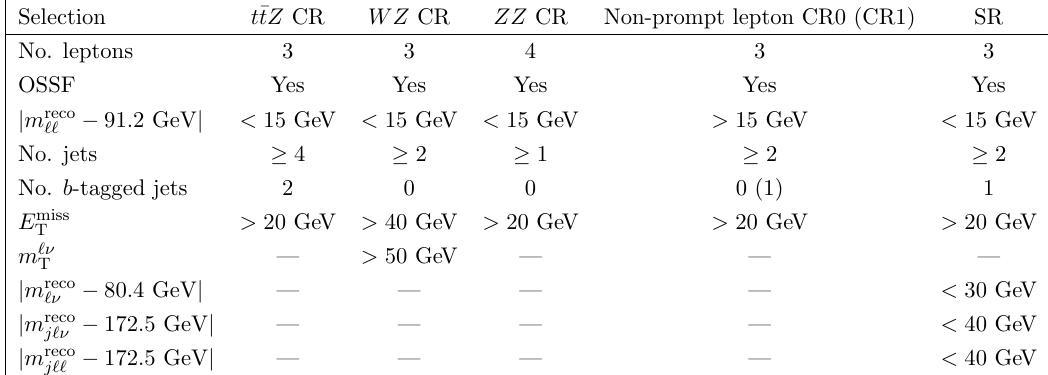
Table 4 . The selection requirements applied for the background control and signal regions. OSSF refers to the presence of a pair of opposite-sign, same-(cid:13)avour leptons. Sample